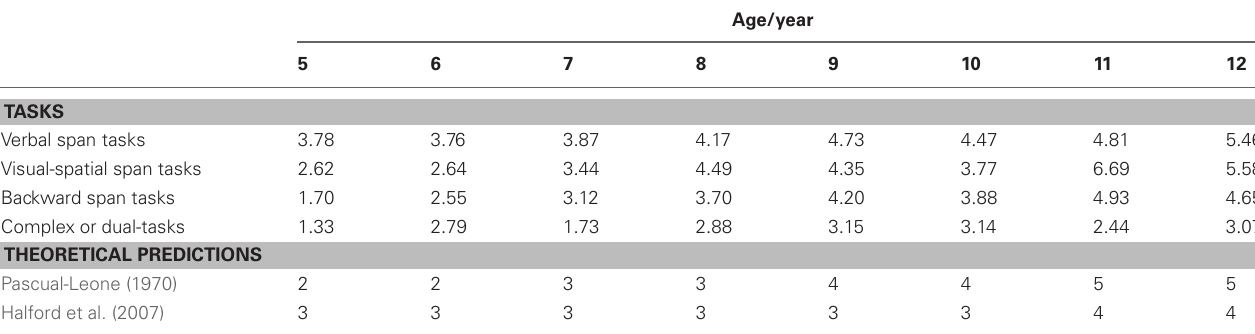
Table 1 | Average estimates of WM capacity by Simmering and Perone (2013) and theoretical